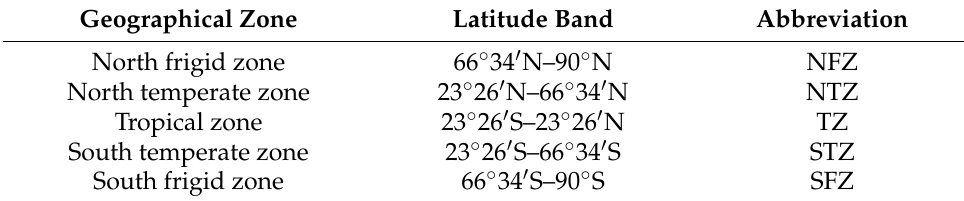
Table 5. The definition of different geographical